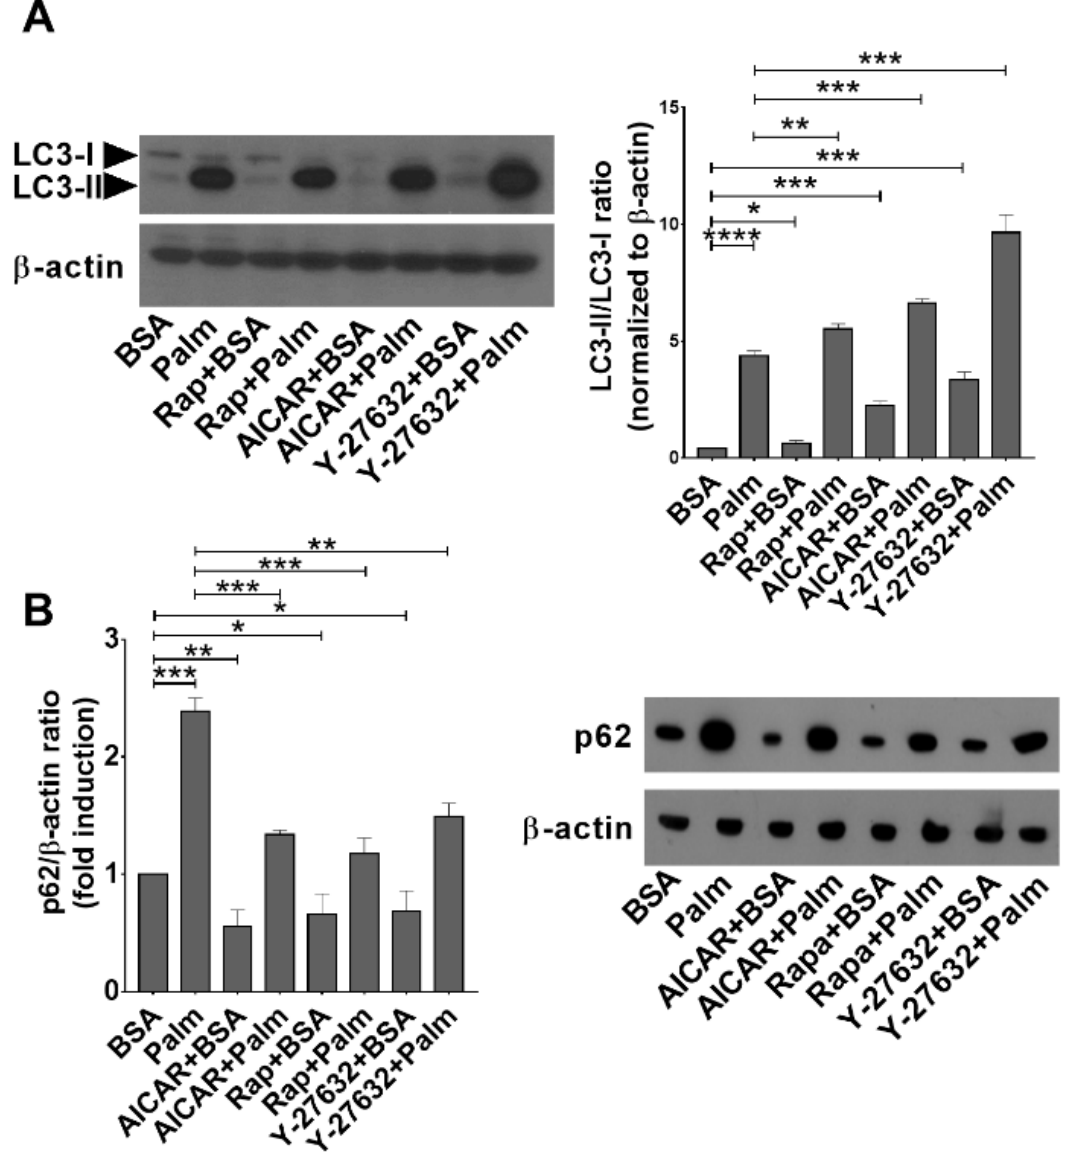
Figure 5. Palmitate exposure induces autophagy but inhibits the fusion of autophagosomes and lysosomes in BMDMs. Administration of AICAR, rapamycin, or Y-27632 interferes with this inhibition. ( A ) Expression of LC3I and LC3II in BMDMs exposed to palmitate for 24 h alone or together with rapamycin (100 nM), AICAR (0.5 mM), or Y-27632 (30 µ M) determined by Western blot analysis. β -actin was used as a loading control. One representative gel of three is shown. ( B ) Expression of p62 in BMDMs exposed to palmitate alone or together with rapamycin (100 nM), AICAR (0.5 mM), or Y-27632 (30 µ M) determined by Western blot analysis. β -actin was used as a loading control. One representative gel of three is shown. All data are expressed as mean ± SD ( n = 3). Asterisks indicate statistically significant difference (* p < 0.05, ** p < 0.01, *** p < 0.001, **** p < 0.0001).